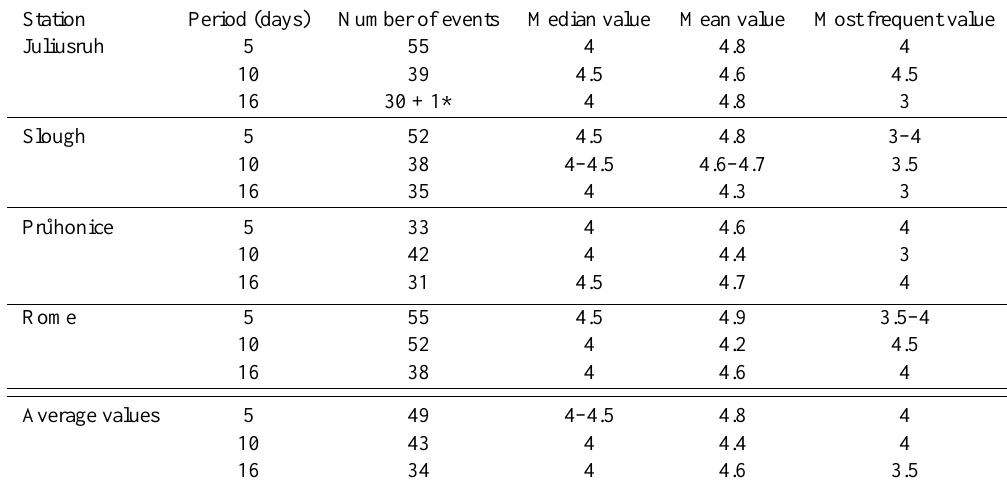
Table 3. Statistics of persistence of planetary wave type oscillations in fo F2 over Europe, 1979–1989, based on the Morlet wavelet transform. The average values for medians and the most frequent values are presented with step 0.5 Station Period (days) Number of events Median value Mean value Most frequent value